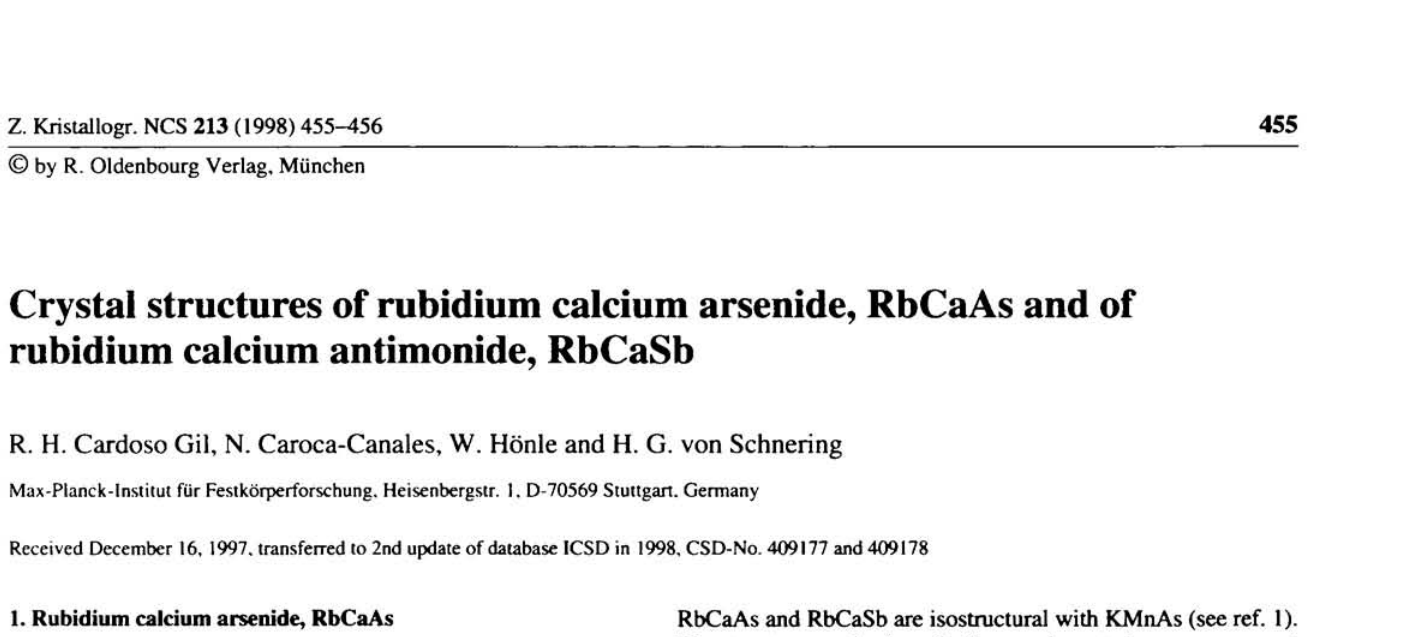
Table 2. Final atomic coordinates and displacement parameters (in A^)